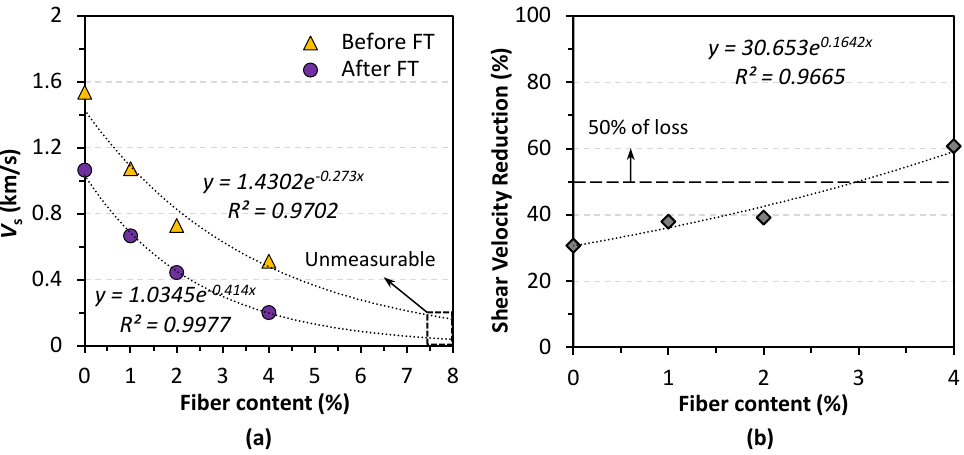
Figure 10. ( a ) Before – after comparison of shear wave velocity; ( b ) shear wave velocity reduction rate.